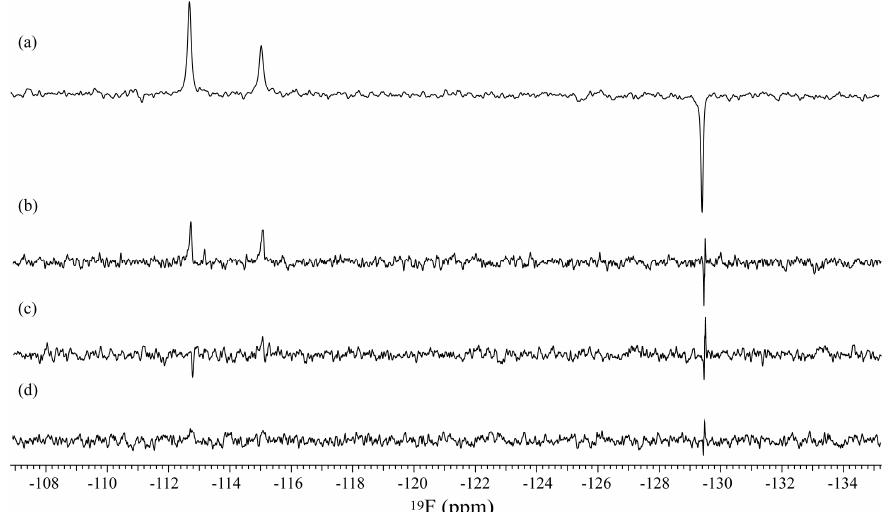
Figure 4. The 19 F-WaterLOGSY spectra acquired using various pulse widths of Gaussian-shaped pulses. The pulse widths ( γ H 1 /2 π ) were ( a ) 2.2 ms (565 Hz), ( b ) 7.0 ms (179 Hz), ( c ) 13 ms (100 Hz), and ( d ) 44 ms (63 Hz). A sample (ii) was used.